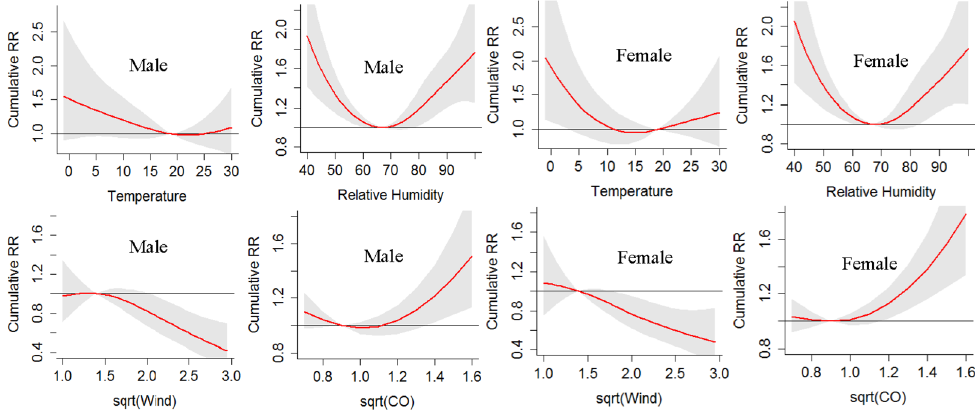
Figure 5. Plots of cumulative RR for Male (left) and Female (right) group: assessing the effect of